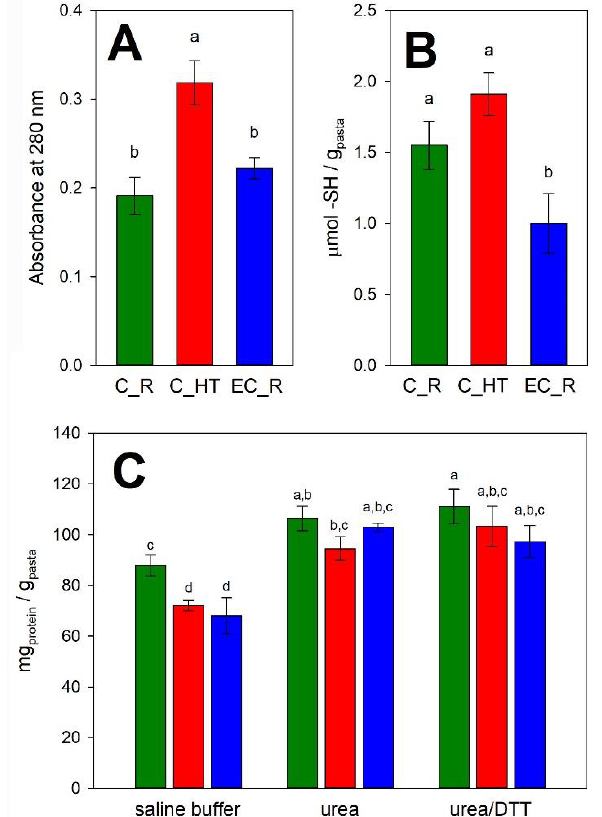
Figure 3. Protein features in pasta from red lentils. Panel ( A ) Protein susceptibility of raw pasta samples to tryptic hydrolysis. Panel ( B ) Amount of accessible protein thiols. Panel ( C ) Protein differential solubility of pasta in non-dissociating (saline buffer), dissociating (urea), and reducing (urea/DTT) buffers. Samples marked with the same letter are not significantly different (Tukey’s HSD; p < 0.05). Green: C_R, pasta from raw red lentils by conventional extrusion; red: C_HT, pasta from heat-treated red lentils by conventional extrusion; blue: EC_R, pasta from raw red lentils by extrusion-cooking.